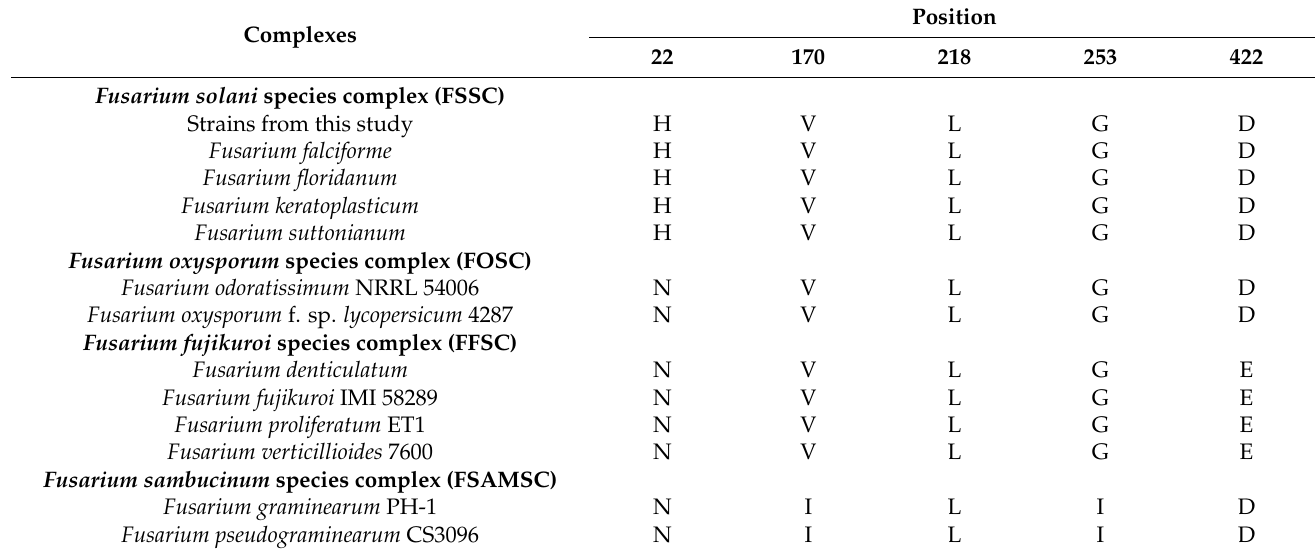
Table 8. Comparison of the five mutations of interest in CYP51A between studied strains and other strains from different species complexes (FSSC, FOSC, FFSC, FSAMSC) (D: aspartic acid; E: glutamic acid; G: glycine; H: histidine; I: isoleucine; L: leucine; N: asparagine; V: valine). Position Complexes 22 170 218 253